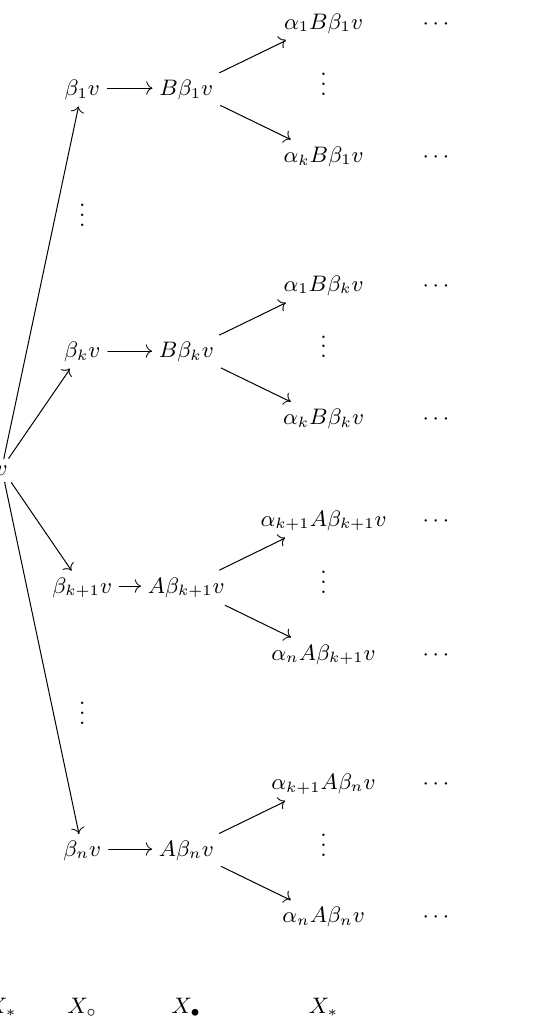
Figure 7 . Skeleton diagram for a Wilson line in the n + 1 dimensional representation of SU(2)